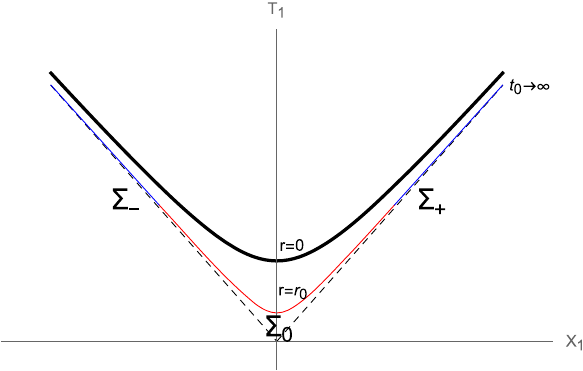
Fig. 14 Schematic representation of the slice t 0 → ∞ . Notice that when t 0 → ∞ , the red line inside the horizon becomes infinitely long and (cid:2) − and, (cid:2) + lie on the horizons, at null